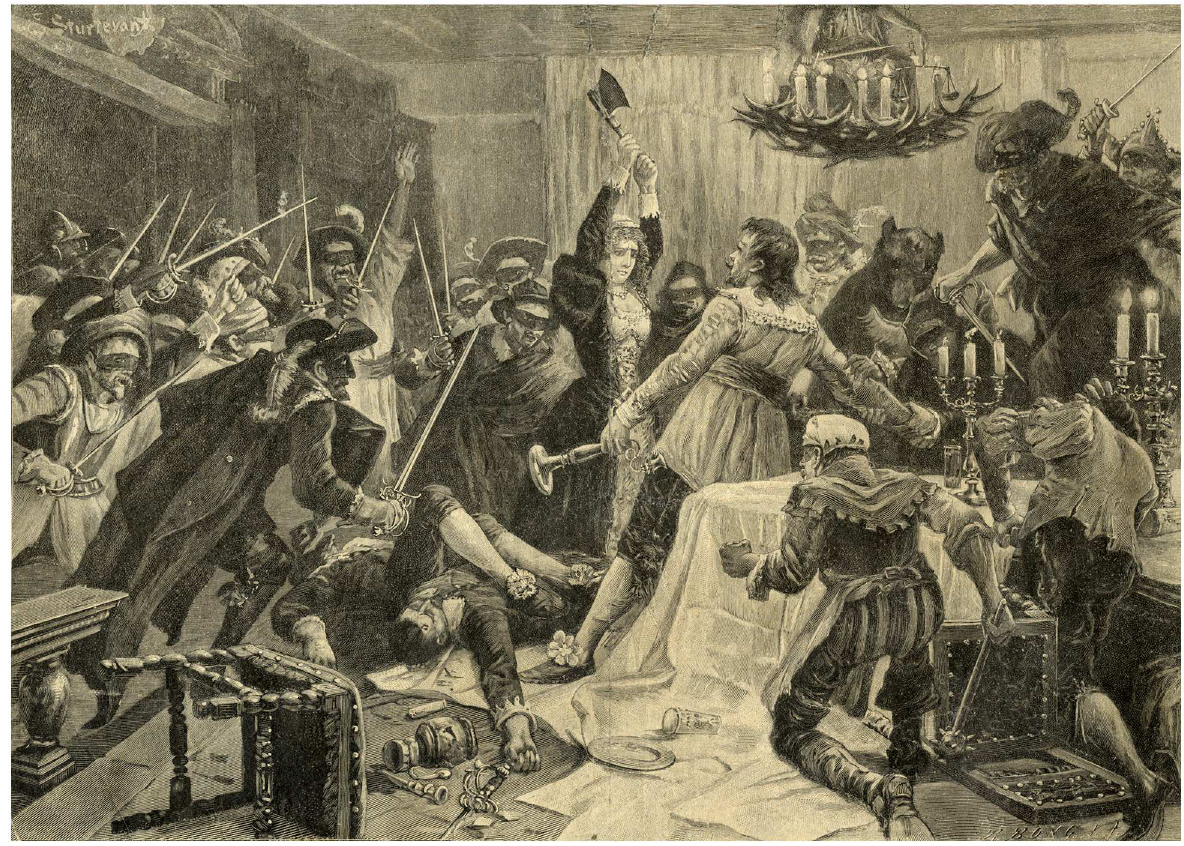
Fig 1. The assassination of Jo¨rg Jenatsch during carnival, 24 th of January 1639, in the tavern “Zum staubigen Hu¨etli” in Chur. Wood engravingby R. Bong after a painting by E. Sturtevant, probablylate 19 th century, Ra¨tisches Museum Inv. No. H1972, 1748. The painting is based on the erroneousaccount in the novel of C.F. Meyer that the imaginaryLucrezia von Planta revengedher father’s death using the same axe with which Jenatsch and his fellows killed Pompeiusvon Planta in 1621 (ref.